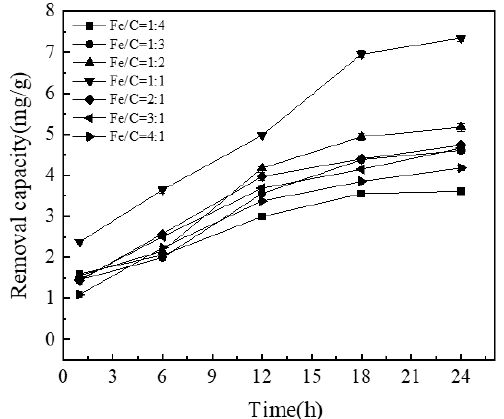
Figure 4. Effect of Fe/C ratio on adsorption capacity of NICLS (activated carbon is wood activated carbon).